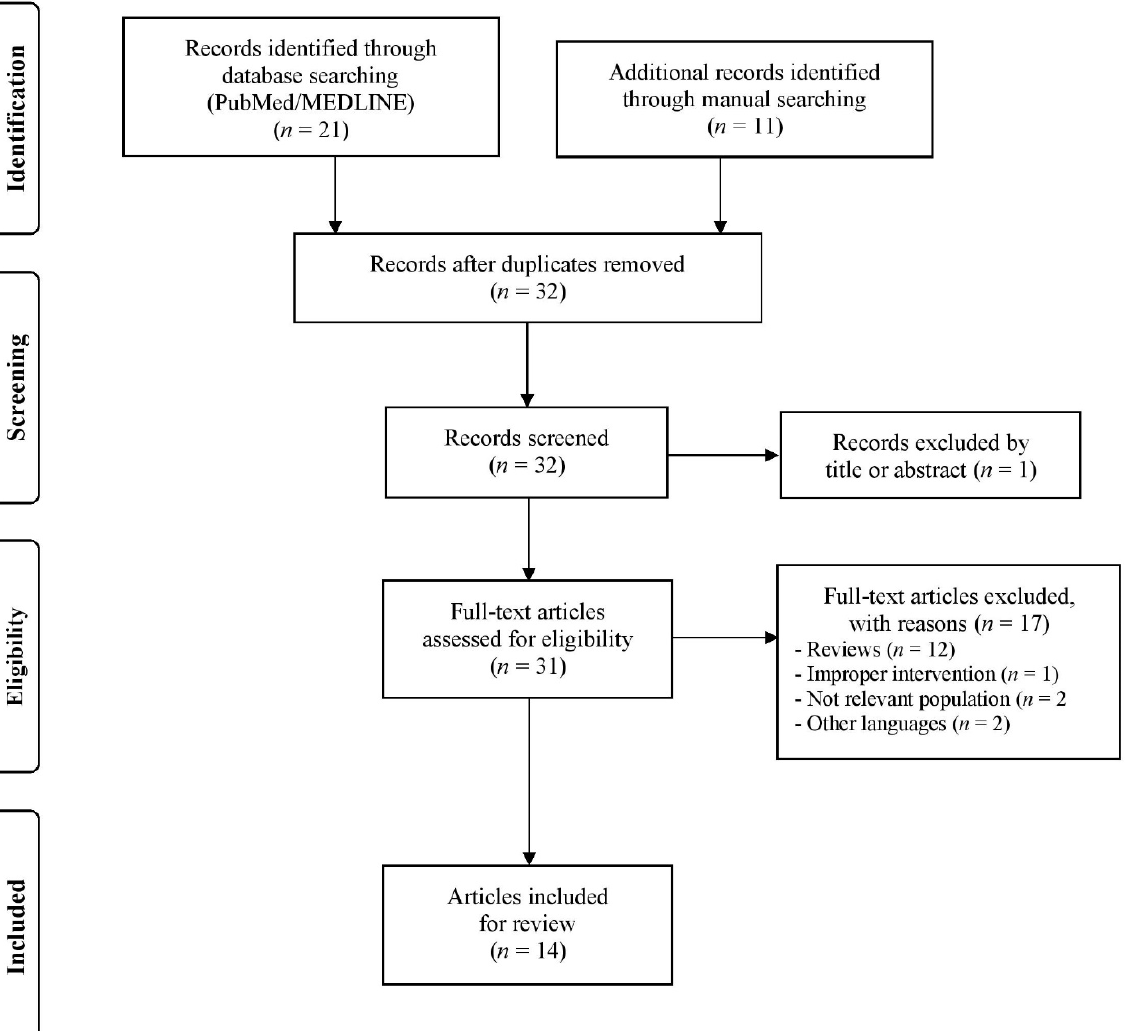
Figure 2. Flowchart of the systematic literature search.